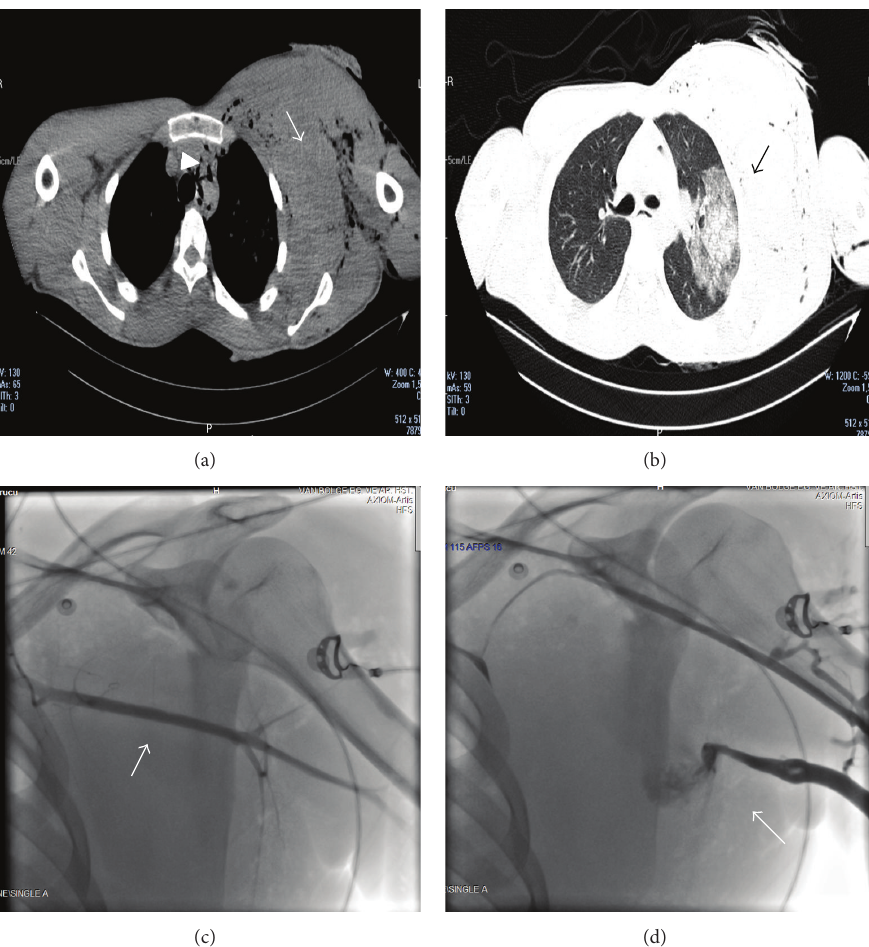
Figure 1: (a) Hematoma, subcutaneous emphysema (arrow) in the left hemithorax, and air in the mediastinum (arrowheads). (b) Pulmonary contusion (arrow). (c) Arteriogram showing patent subclavian artery (arrow). (d) Venogram demonstrating extravasation from axillary vein